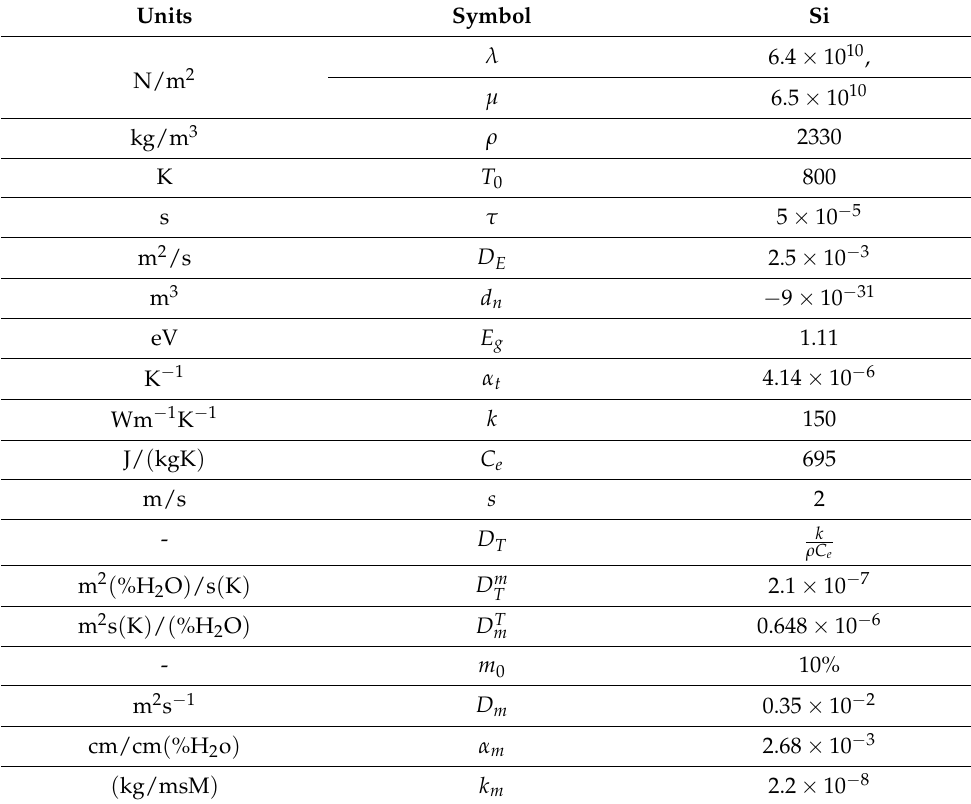
Table 1. Physical constants of Si